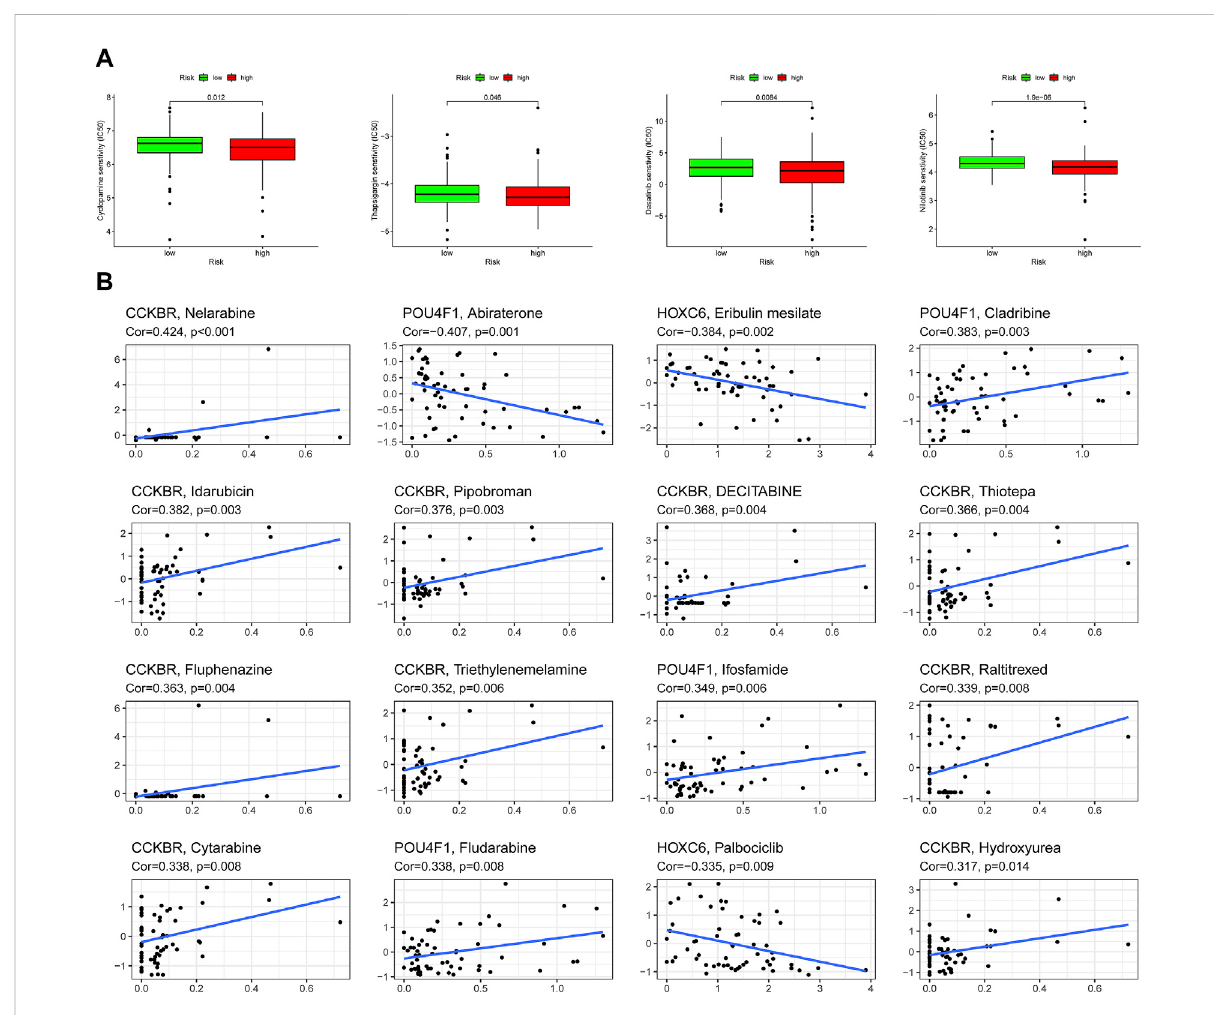
FIGURE 9 Chemosensitivity analysis in high-risk and low-risk groups. (A) Estimation of IC50 value for cyclopamine, thapsigargin, dasatinib, and nilotinib. (B) Scatter plot of the association between 3 ERGs expression and drug